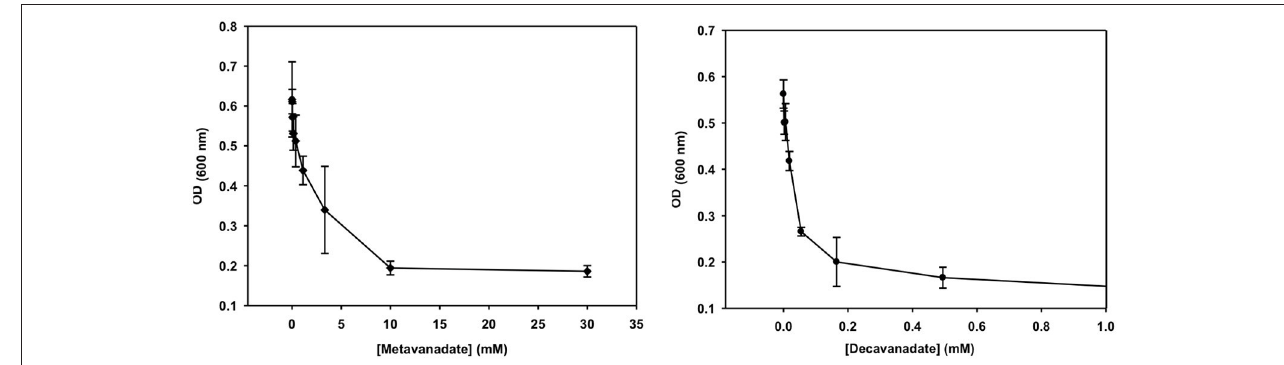
FIGURE 4 | The growth curve is shown for treatment with vanadate (left, prepared from a 40mM colorless metavanadate solution) and decavanadate [right, prepared from a 100mM orange decavanadate solution (1.0M V-atoms) on M. tb ].